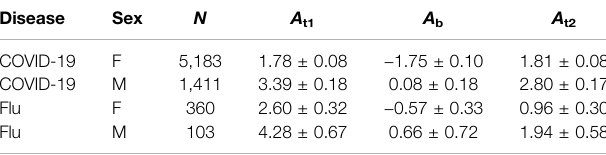
TABLE 3 | Estimation of peak amplitudes. Disease